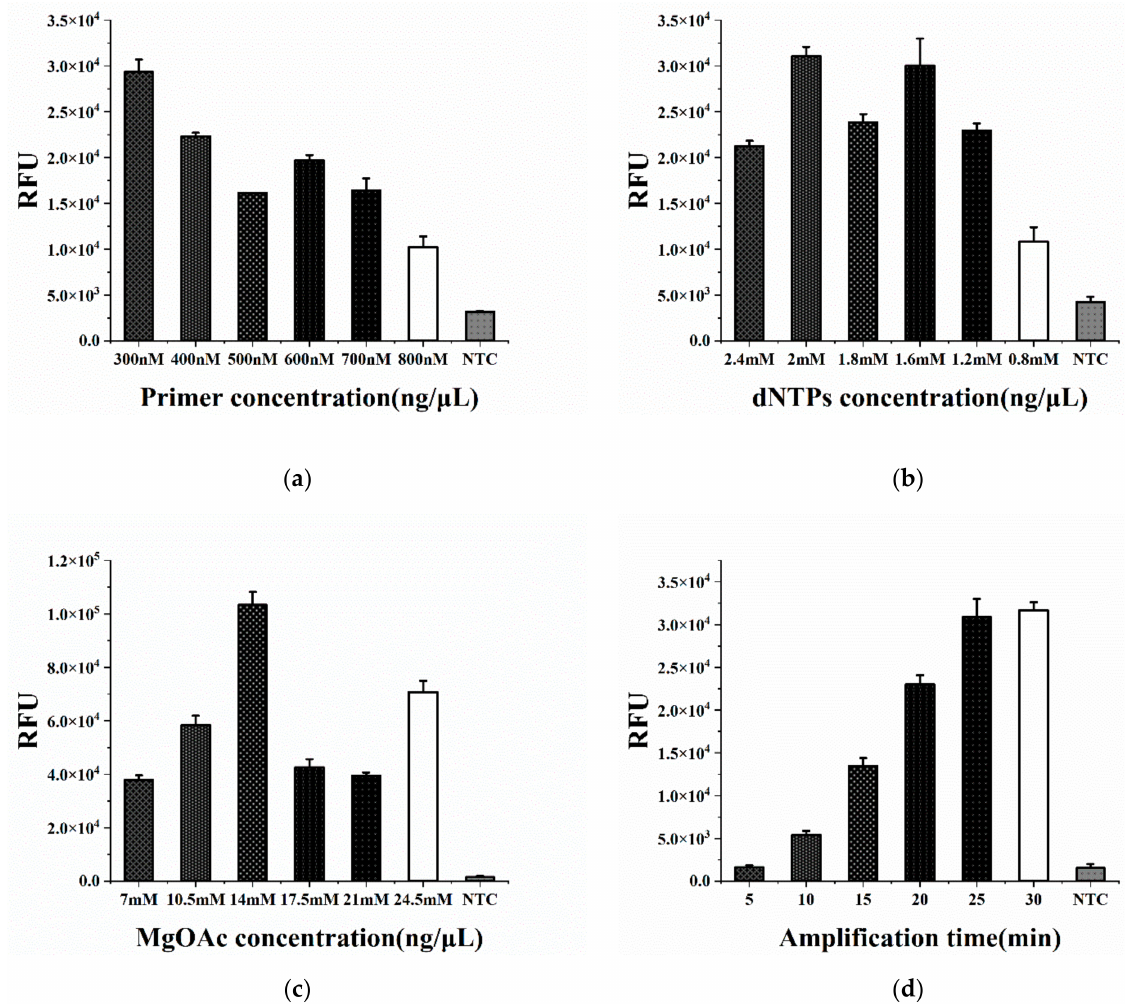
Figure 2. Condition optimization of RPA amplification system. ( a ) Primer concentration. ( b ) dNTPs concen-tration. ( c ) MgOAc concentration. ( d ) Amplification time. NTC: nontarget